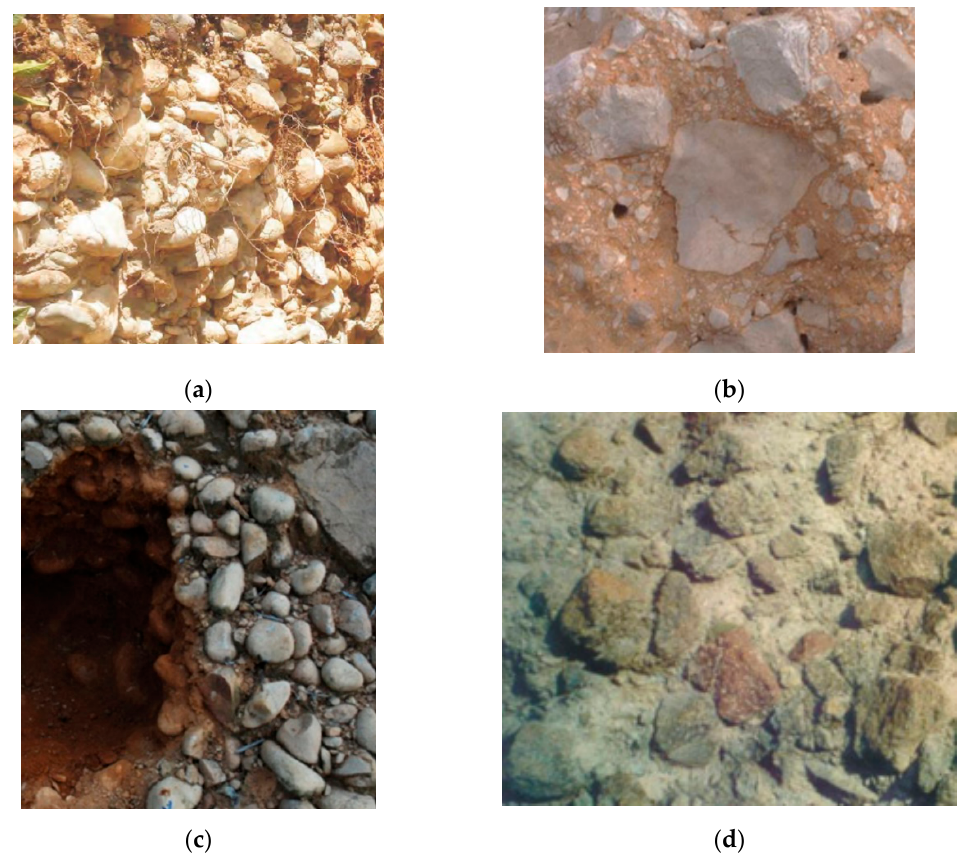
Figure 1. Samples of the bimrocks with high rock block proportions. ( a ) Ice-water accumulated bimrocks. ( b ) Bimrocks of misis fault breccia. ( c ) Bimrocks of gravel deposit. ( d ) Volcanic bimrocks.